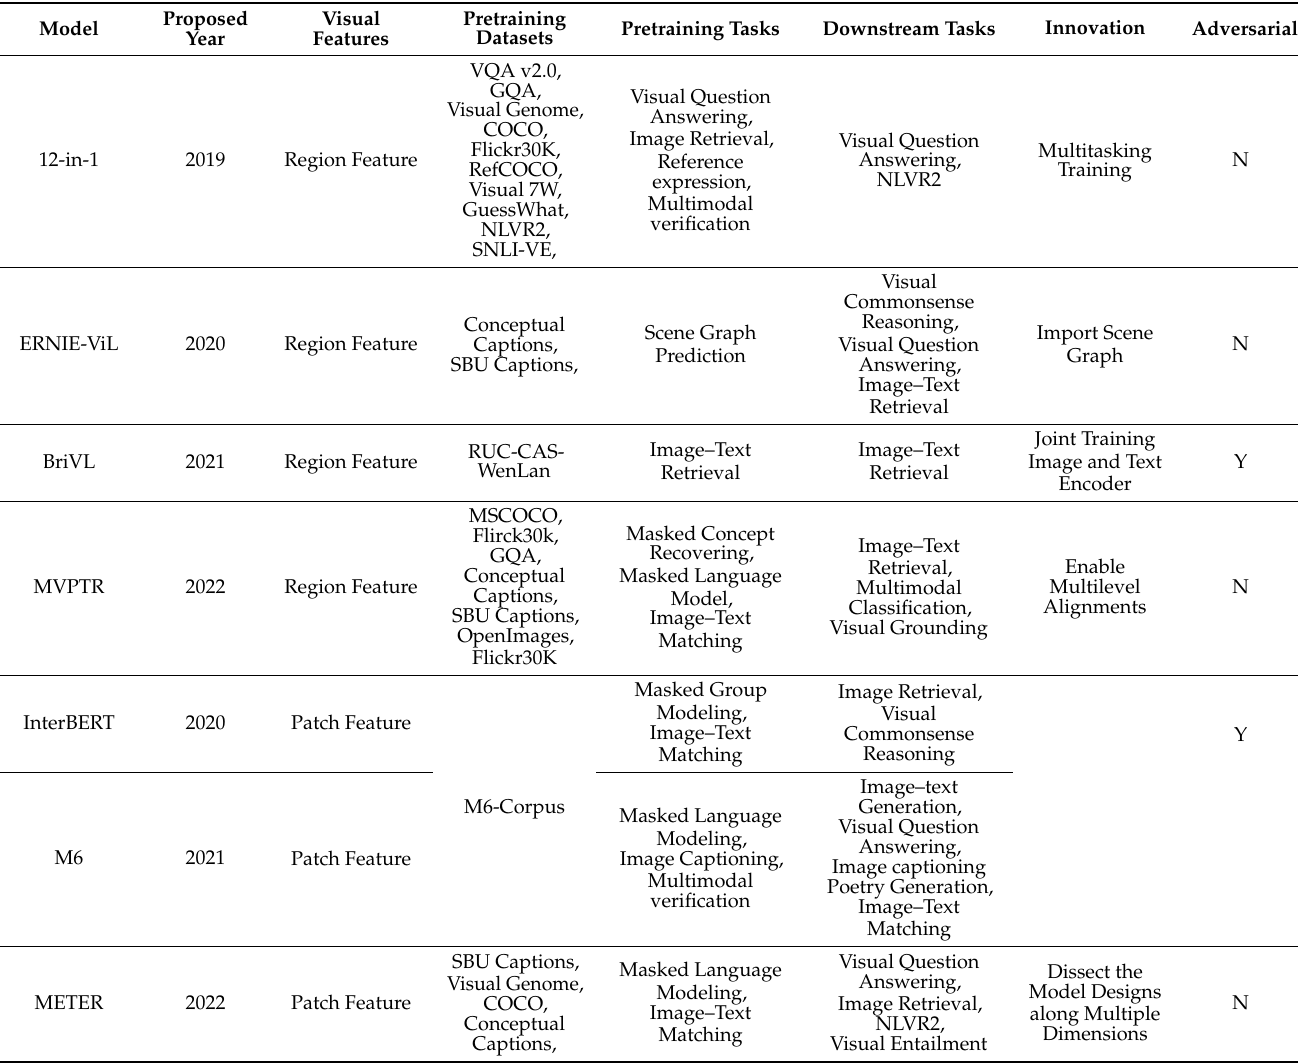
Table 9. Comparison of Dual Stream Architecture Image–Language Pretraining